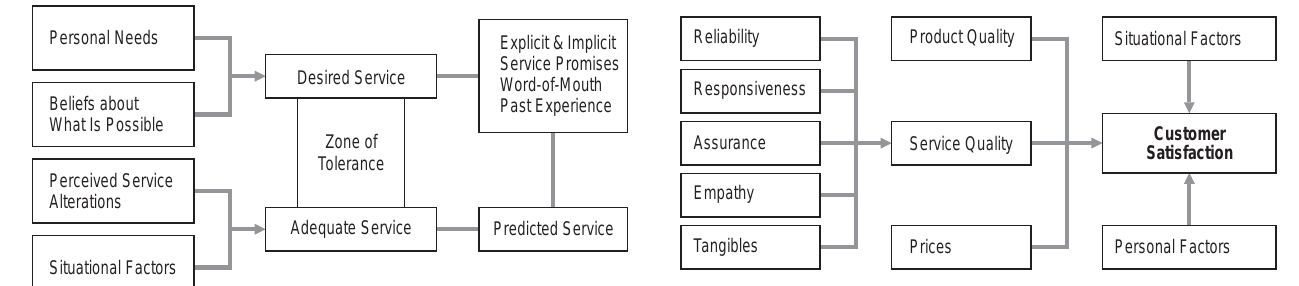
Fig. 4. Components of customer